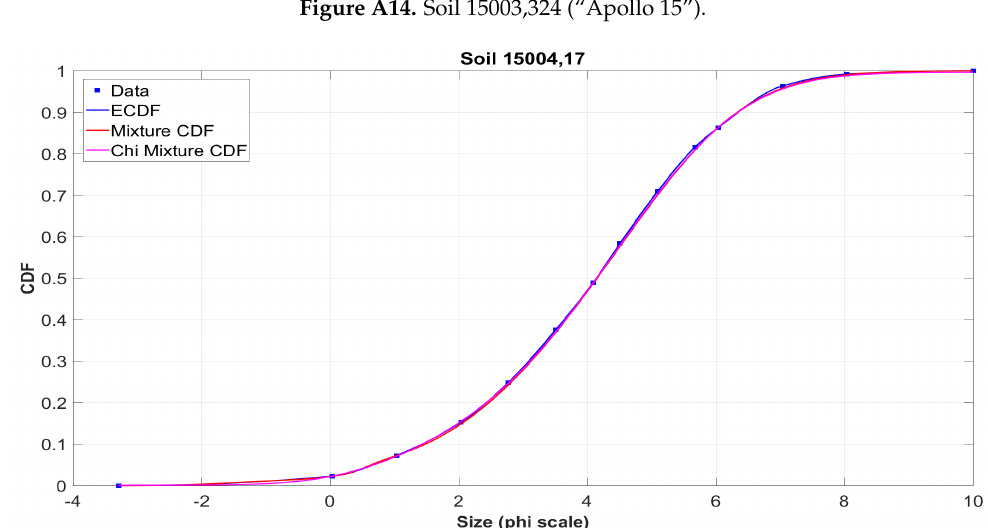
Figure A14. Soil 15003,324 (“Apollo 15”).